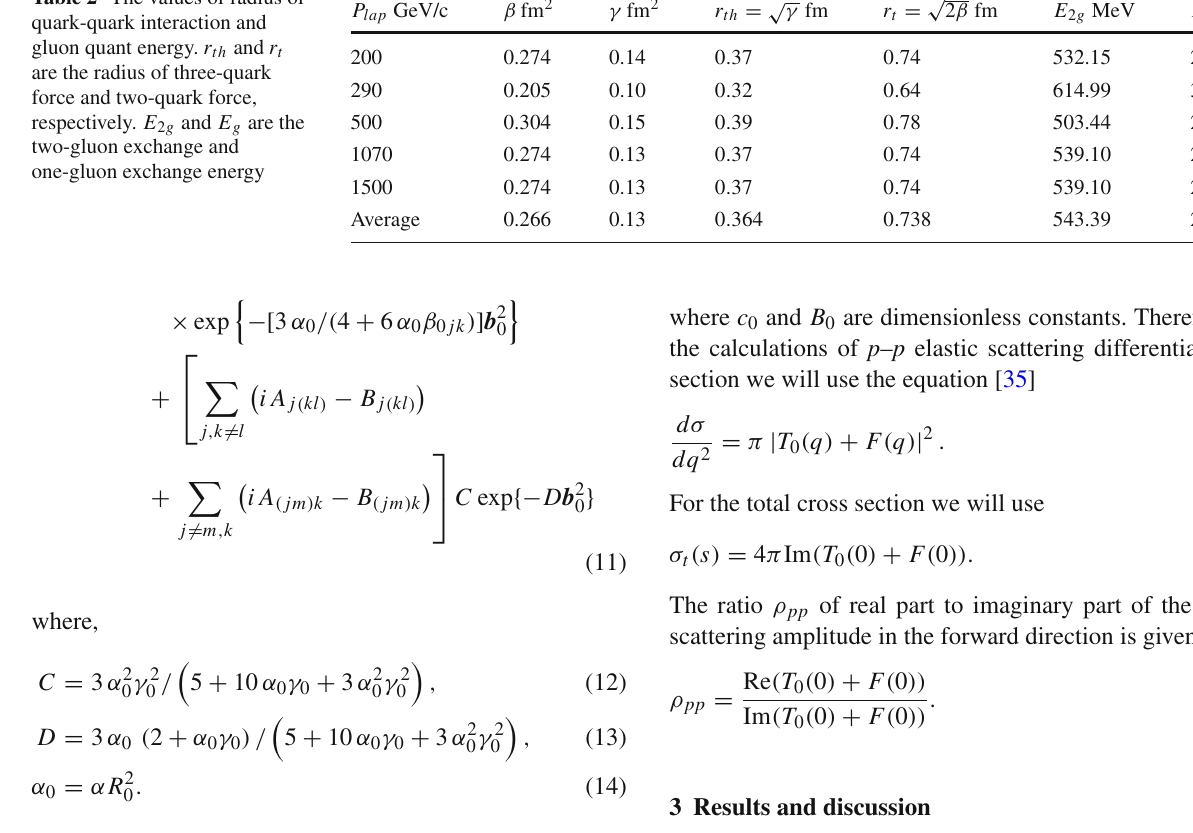
P lap GeV/c β fm